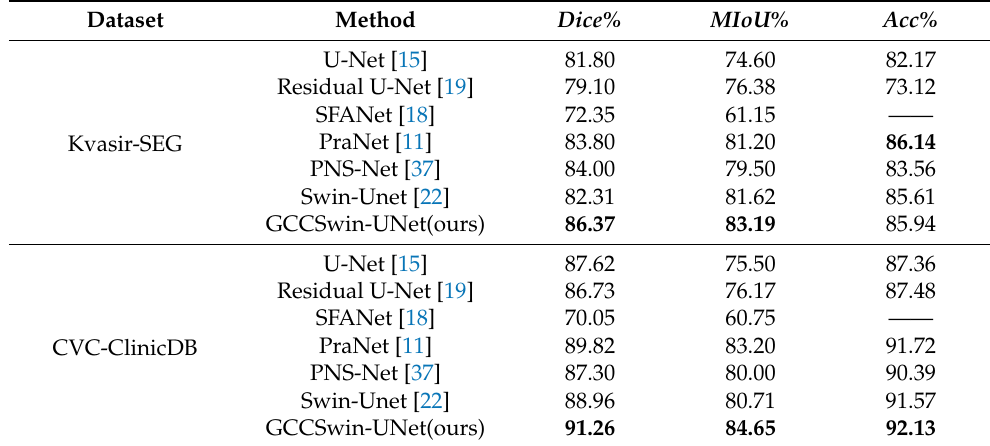
Table 2. The comparison of other state-of-the-art networks with our